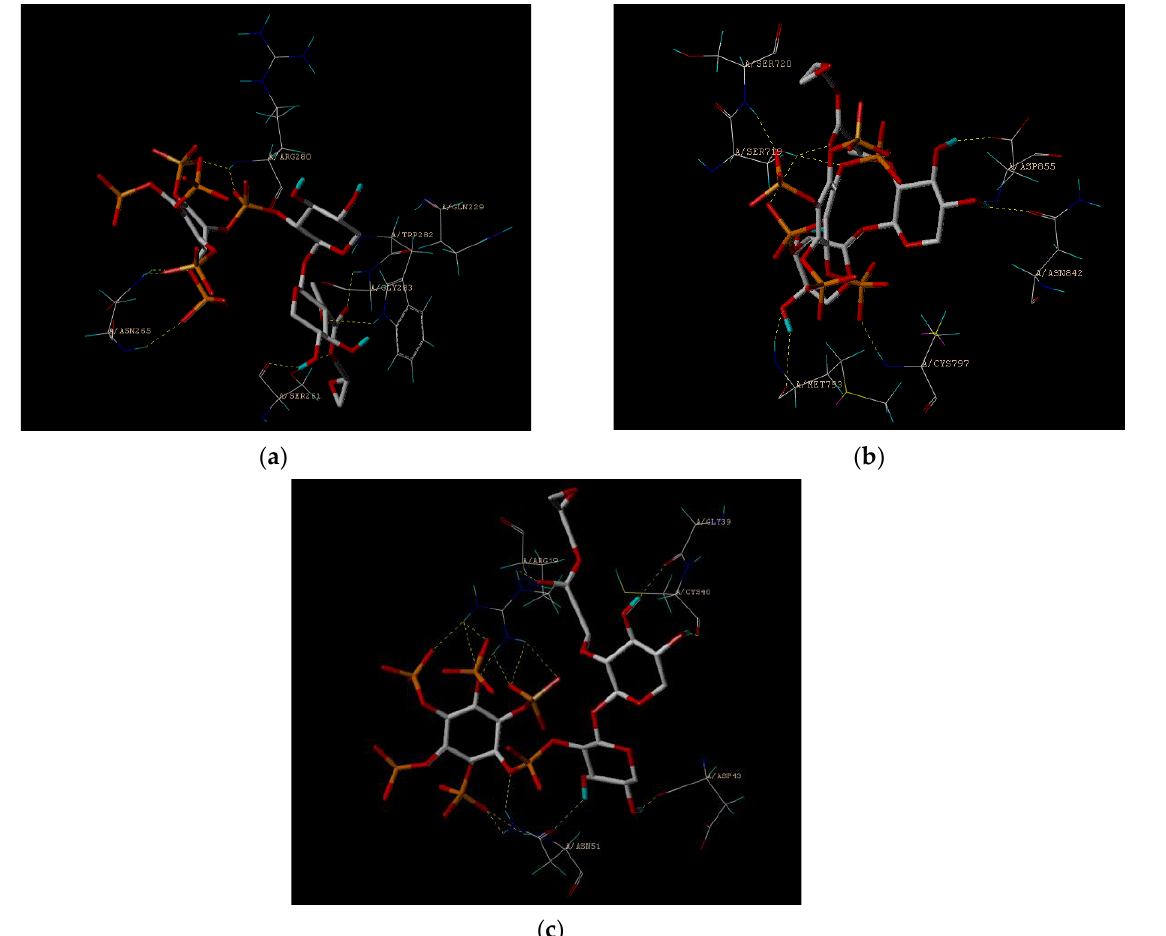
Figure 9. Images of the GMA BX-PA link to the amino acid residue. ( a ) An image of the GMA BX-PA link to the amino acid residue of 5XNV. ( b ) An image of the GMA BX-PA link to the amino acid residue of 2EB2. ( c ) An image of the GMA BX-PA link to the amino acid residue of 2M6N.